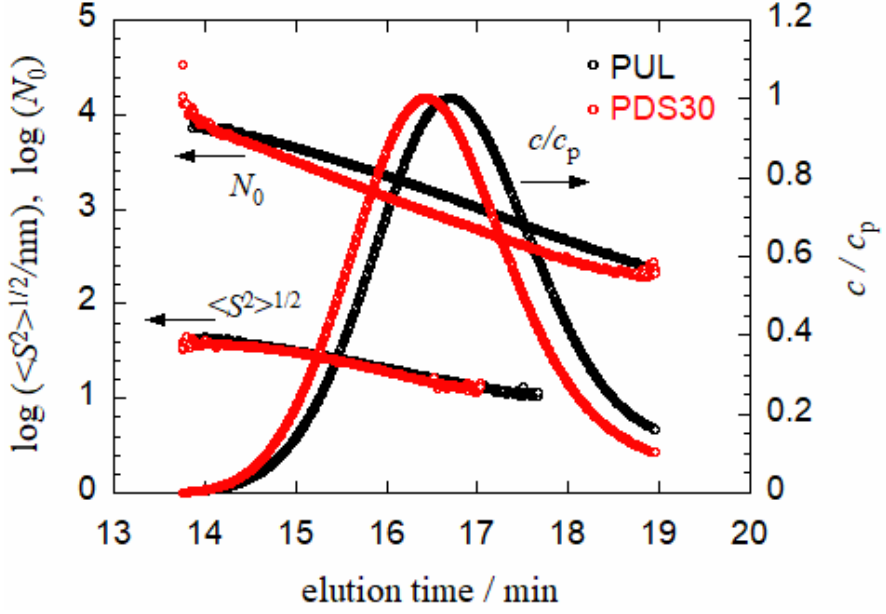
samples in the SEC column. In fact, the total concentration of PUL-OSA eluted from SEC slightly decreased with increasing DS . Figure 1. Elution curves (the polymer mass concentration c divided by the peak concentration c p ) and elution time dependences of the degree of polymerization N 0 and the radius of gyration  S 2  1/2